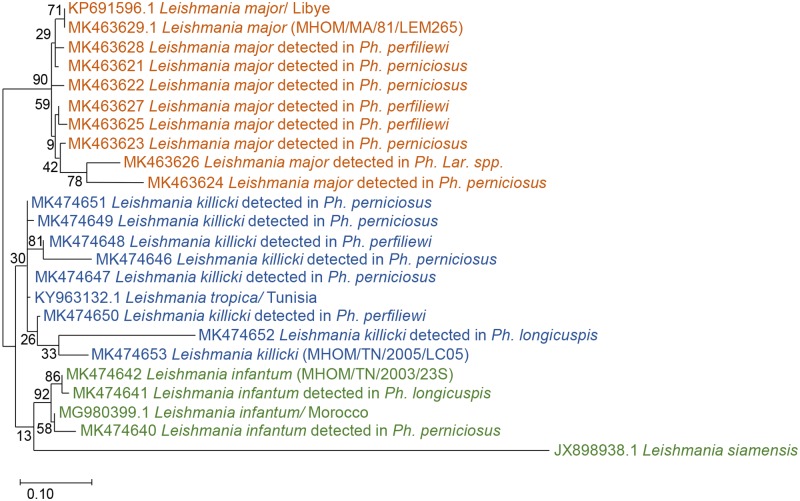
Phylogenetic analysis by Maximum Likelihood method based on Leishmania ITS1 sequences.The numbers above the branches indicate the bootstrap sampling percentages.